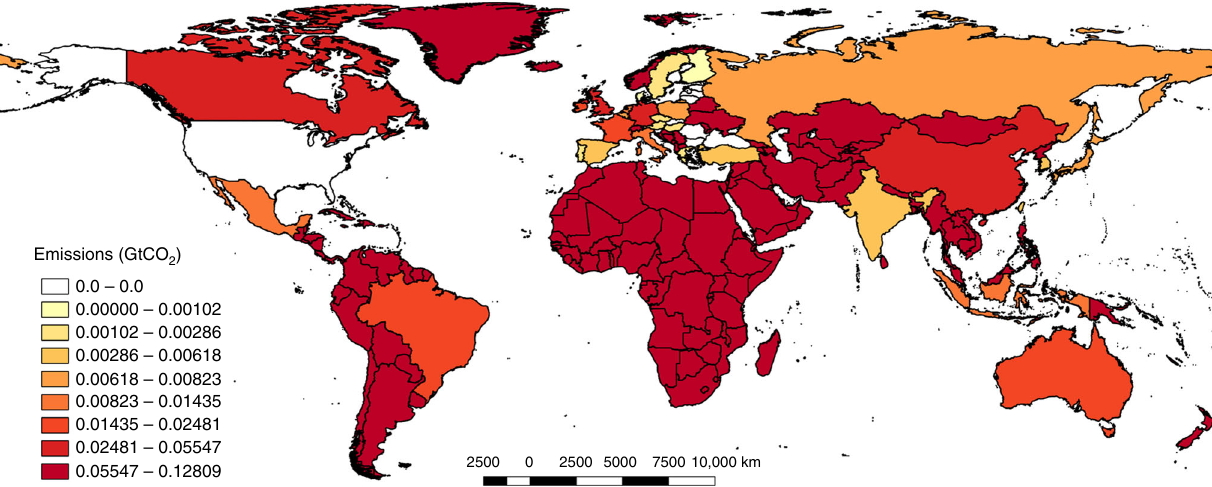
Fig. 2 US-MNE carbon footprint by host country, the producer footprint (GtCO 2 ). This study covers the following 27 EU countries and 13 other major countries (using ISO 3166 – 1 alfa-3 country codes): AUS, AUT, BEL, BGR, BRA, CAN, CHN, CYP, CZE, DEU, DNK, ESP, EST, FIN, FRA, GBR, GRC, HUN, IDN, IND, IRL, ITA, JPN, KOR, LTU, LUX, LVA, MEX, MLT, NLD, POL, PRT, ROU, RUS, SVK, SVN, SWE, TUR, TWN, and USA. The remaining non-covered part of